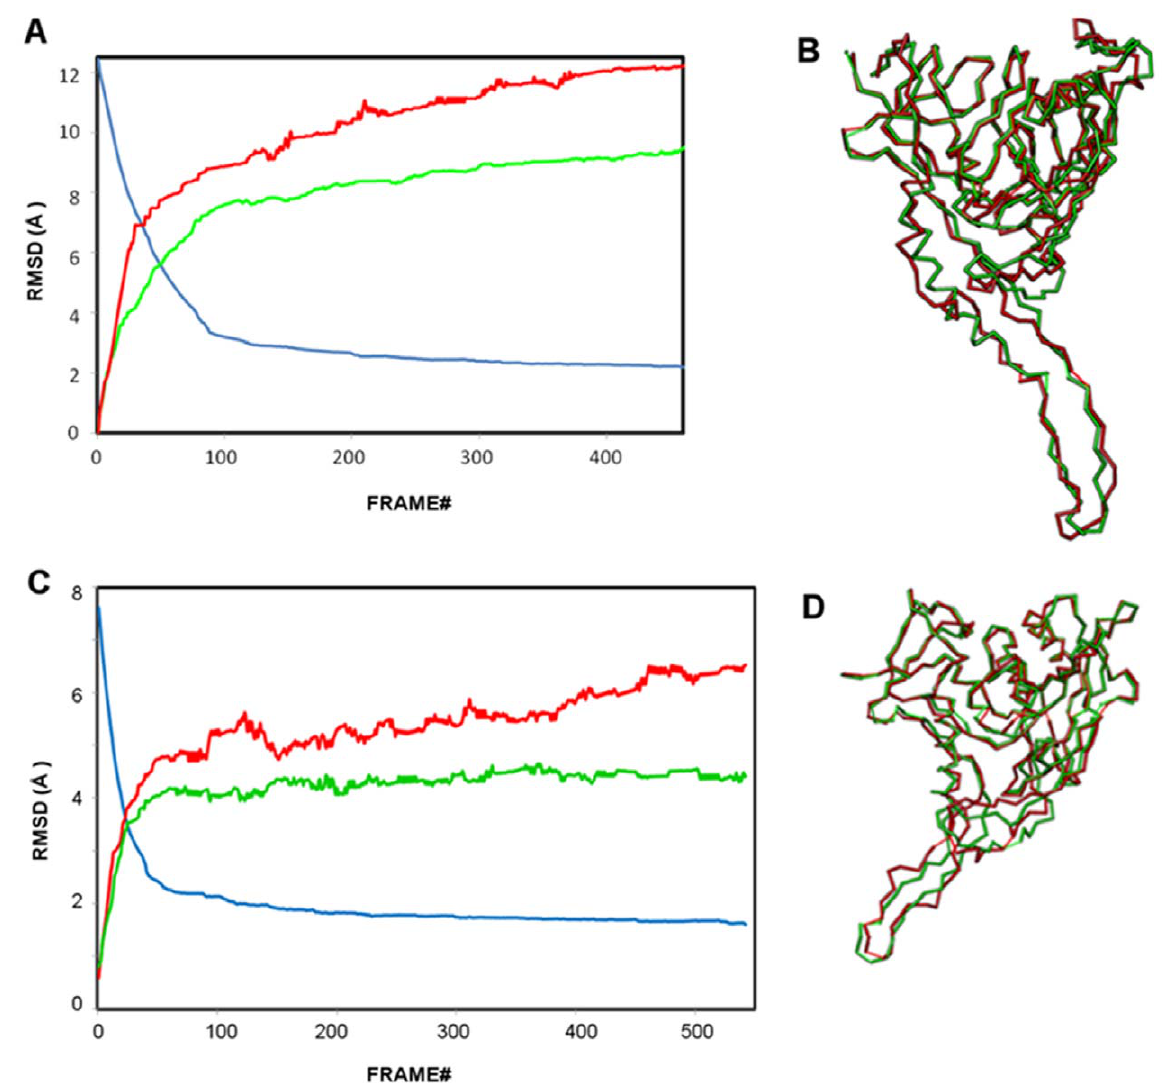
Figure 10. The convergence of gp120 conformational transitions. ( A ) RMSD profiles for the gp120 conformational transition between CD4- and b12-bound states. Blue curve: The RMSD between the intermediate states generated from CD4- and b12-bound states. Red curve: RMSD between the initial b12-bound state and the intermediates generated from this state. Green curve: RMSD between the initial CD4-bound state and the intermediates generated from this state. ( B ) Superposition of C a backbones of terminal intermediate structures originating from CD4-bound (green) and b12-bound (red) states. ( C ) RMSD profiles for the gp120 conformational transition between CD4- and F105-bound states. Colors are as for (A) but apply to F105 rather than b12. ( D ) Superposition of C a backbones of terminal intermediate states originating from CD4-bound (green) and F105-bound (red) states.